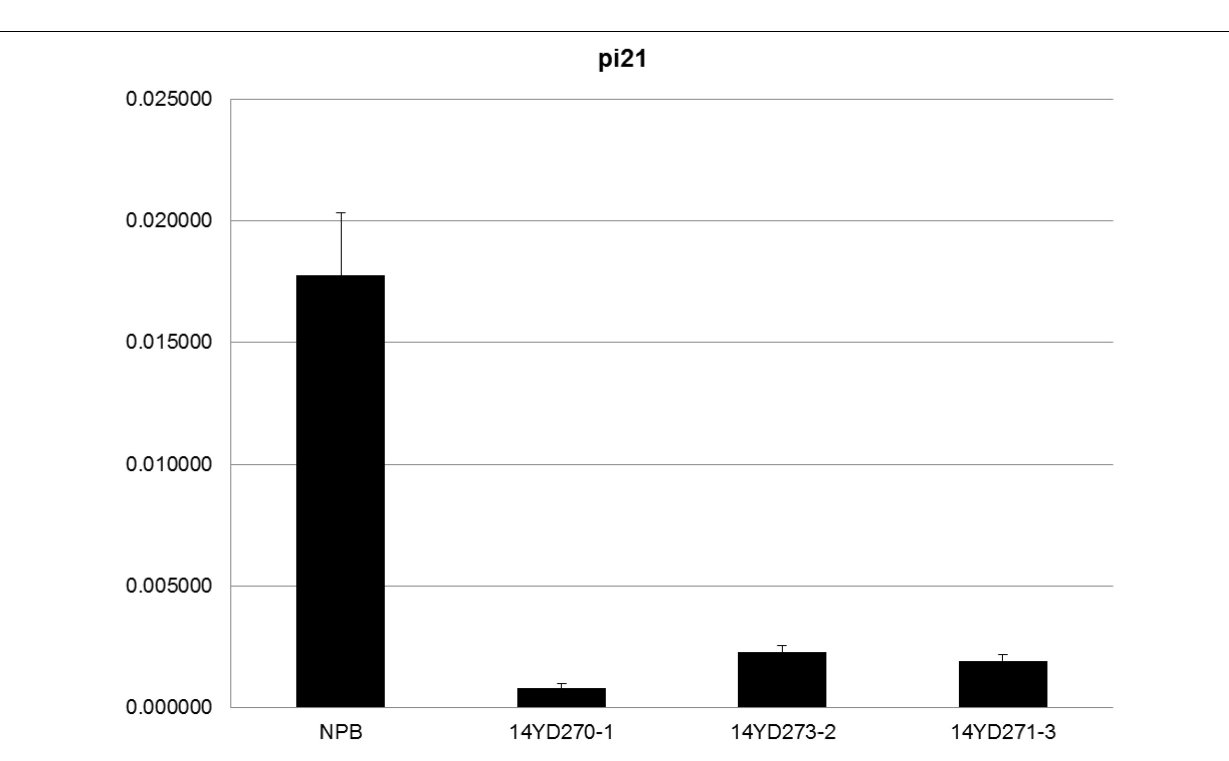
FIGURE 5 | qRT-PCR analysis of Pi21 transcript levels in pBDL23-transformed marker-free rice. Horizontal axis: Wild-type control (NPB) plants and T2 homozygote plants from transgenic lines 14YD270-1, 14YD273-2, and 14YD271-3, respectively; Longitudinal axis: Relative expression levels of Pi21 ( OsEF-Tu was used as an internal